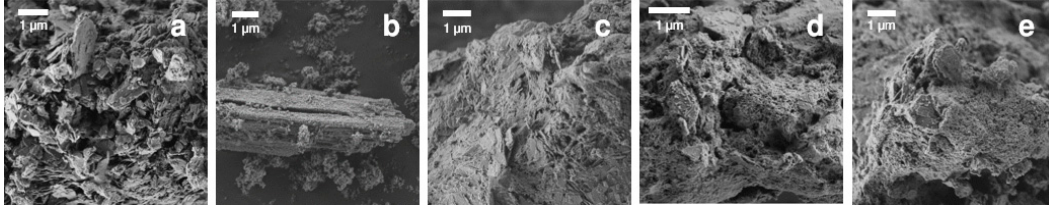
Figure 4. FE-SEM images of ( a ) CLI, ( b ) SnO 2 , ( c ) SnO2CLI05, ( d ) SnO2CLI15, and ( e ) SnO2CLI25.